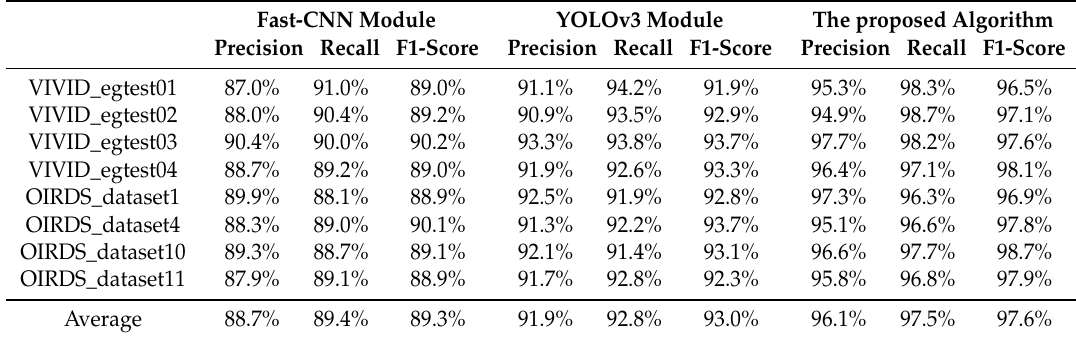
Table 2. Quantitative results on the four test image sequences.